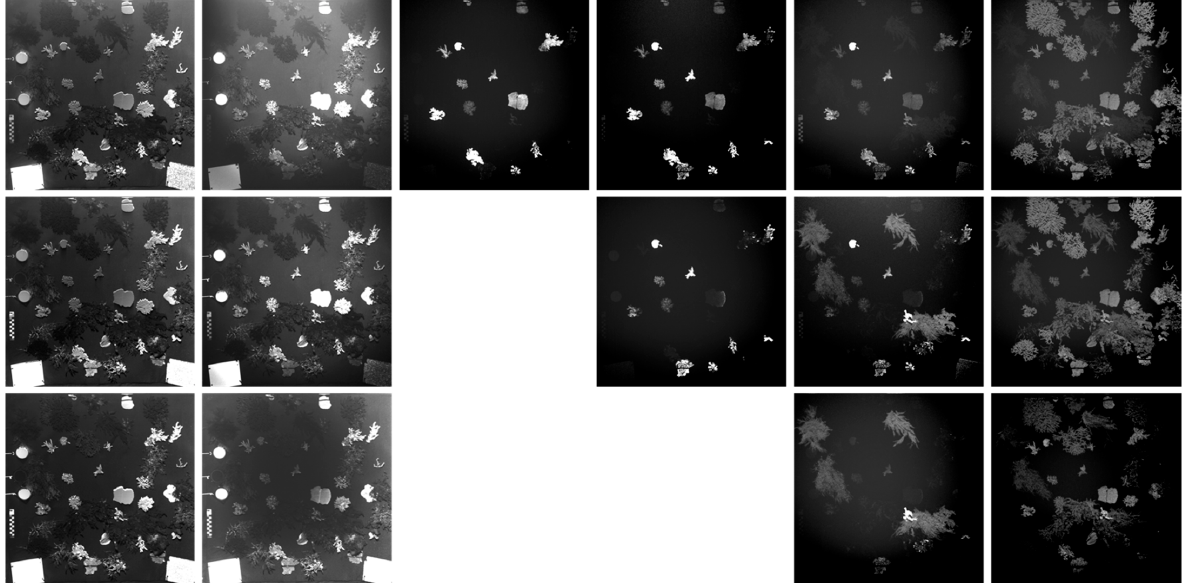
Figure 6. Images recorded through spectral response of macroalgae and coral species from excitation at 450 nm (top row), and from left, reflectance at 450 nm without filter, 450 nm with bandpass filter, emission at 490 nm, 520 nm, 580 nm, and 685 nm; excitation from left, at 490 nm (middle row), and from left, reflectance at 490 nm without filter, 490 nm with bandpass filter, emission at 520 nm, 580 nm, and 685 nm, and excitation from left at 520 nm (bottom row), and from left, reflectance at 520 nm without filter, 520 nm with bandpass filter, and emission at 520 nm, 580 nm, and 685 nm.